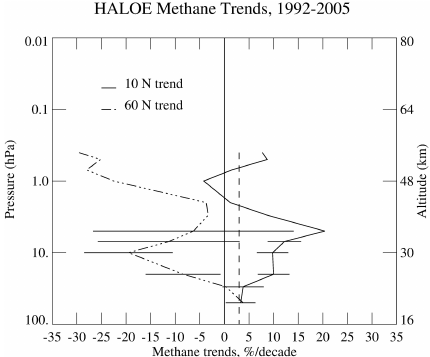
Figure 9. As in Fig. 8, but for the Northern Hemisphere.